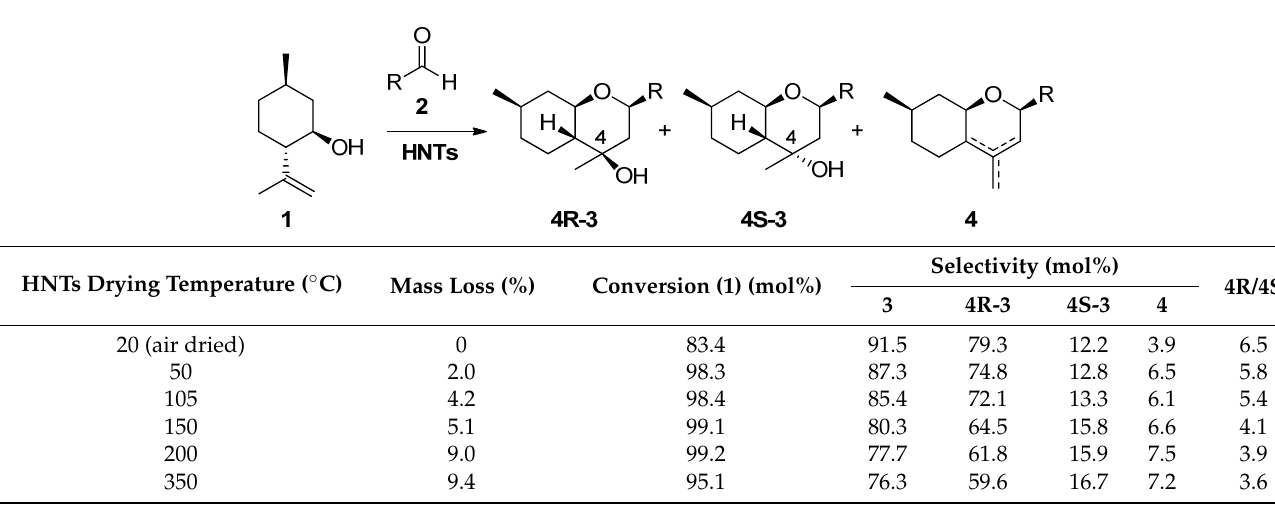
Table 2. Conversion of isopulegol a and product selectivity b .